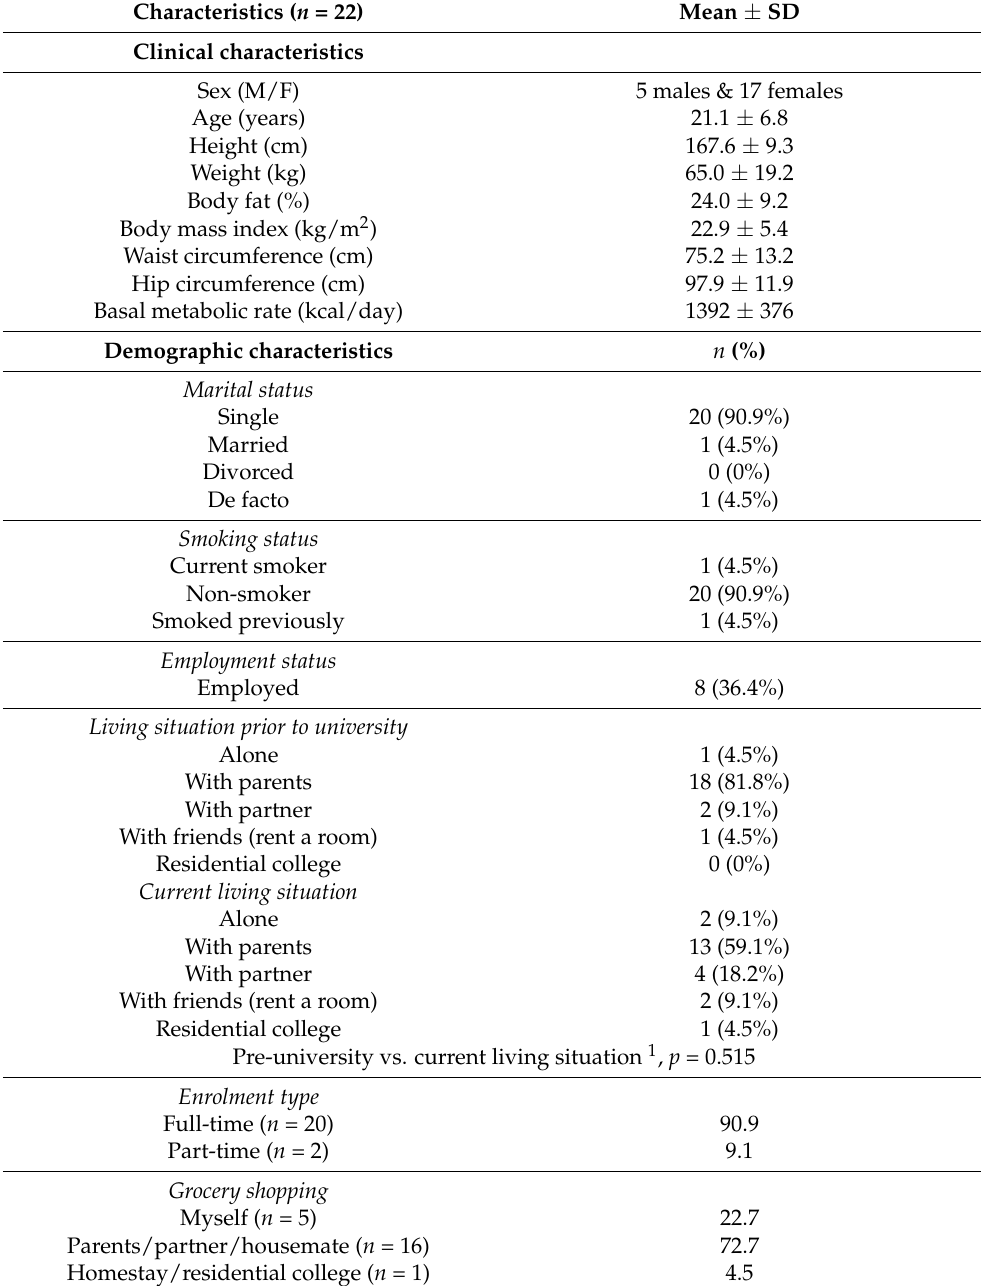
Table 1. Baseline demographics and characteristics of 22 first-year university students from an Australian